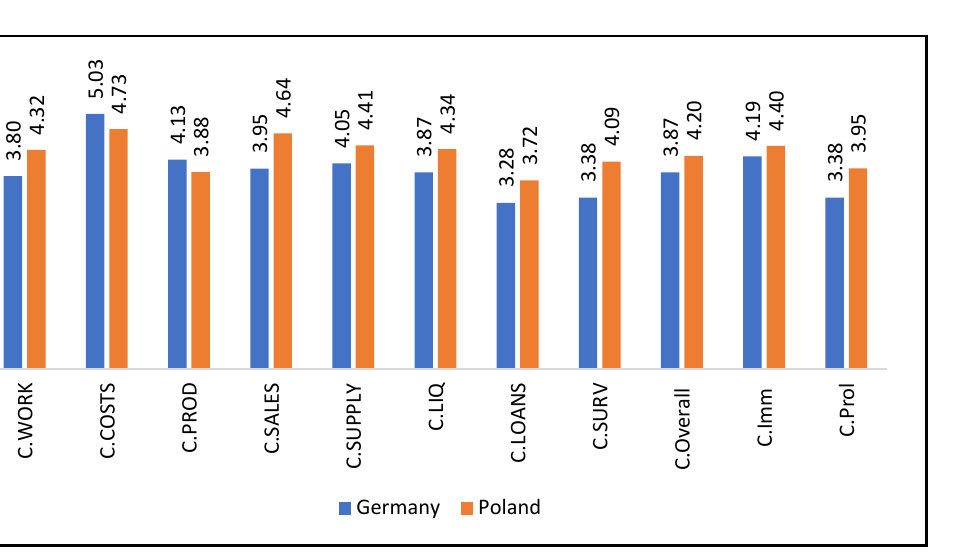
Figure 2. COVID-19 impacts construct: Survey results for SMEs in Germany and Poland. Table 6. COVID-19 impacts construct: SMEs in Germany vs. SMEs in Poland. Variable